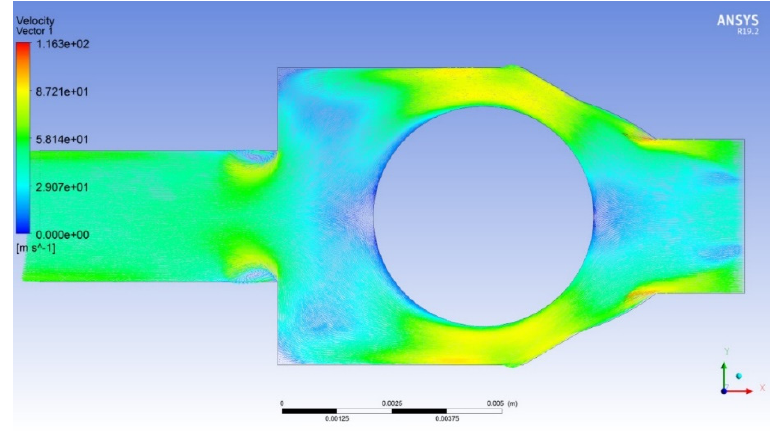
Figure 18. Velocity CFD: Spherical Seat Valve: x = 1.257 [mm], pdn = 2000 [bar] and pup = 2100